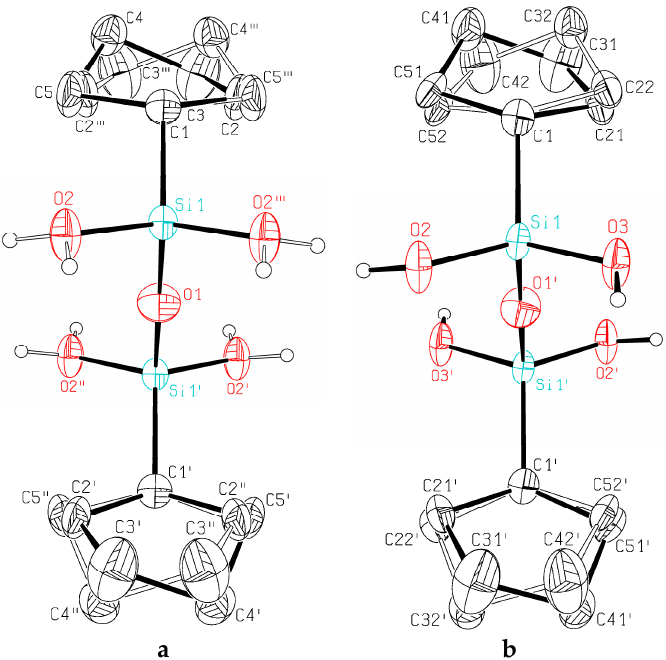
Figure 1. This ORTEP plot of the molecular structure of 2 from the monoclinic ( b ) and the orthorhombic ( a ) polymorph showing the atomic numbering scheme. The probability ellipsoids are drawn at the 50% probability level. The cyclopentyl rings are disordered over two sites. The H atoms bonded to oxygen are drawn with arbitrary radii, the H atoms of the cyclopentyl rings were omitted for the sake of clarity. Red: oxygen; blue: silicon.